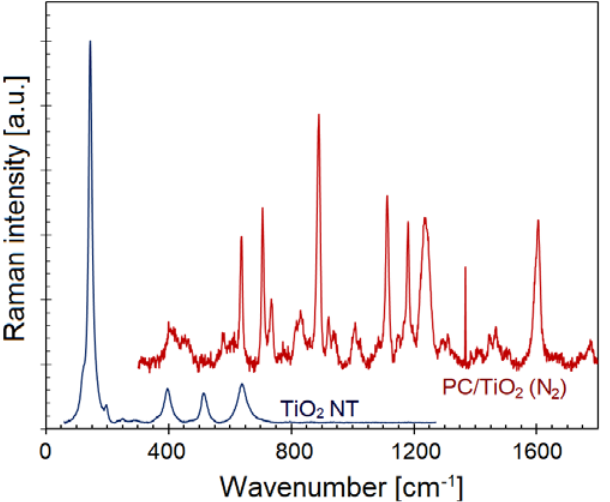
Figure 5. Raman spectra of the TiO 2 HN powder hydrothermal synthesis and PC/TiO 2 -NW0.10 composite. Table 1. Assignment of Raman modes in pure TiO 2 powder and PC/TiO 2 -0.10NW